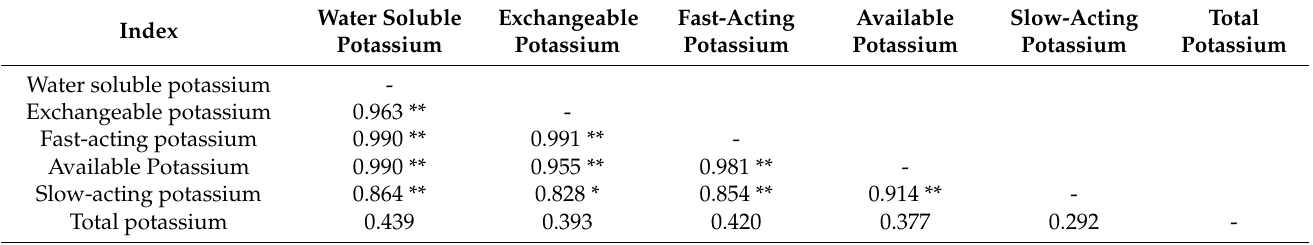
Table 3. Correlation among various forms of potassium in the rhizosphere soil of Paris polyphylla var. yunnanensis